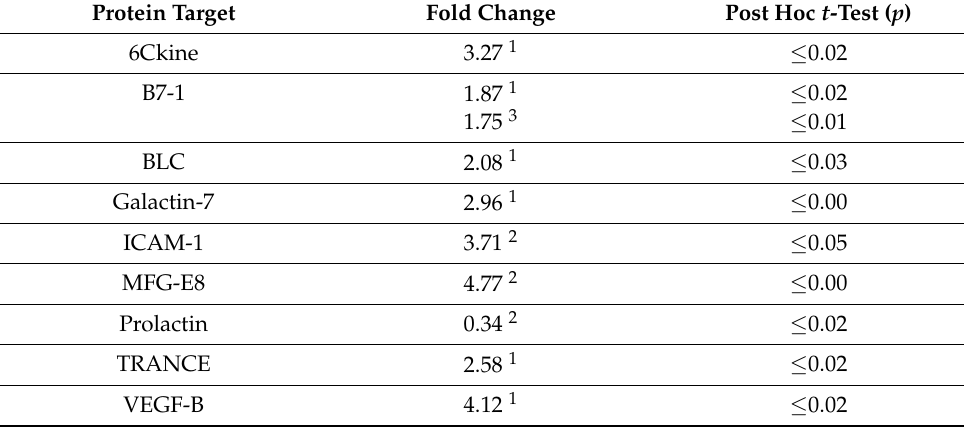
Table 3. Differentially expressed plasma proteins dependent on